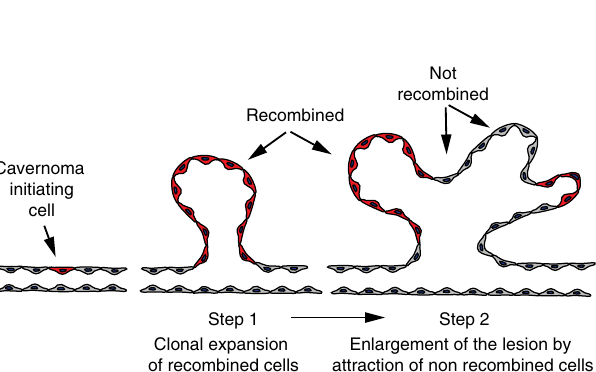
Fig. 8 Endothelial progenitors are involved in cavernomas formation. a In situ hybridization for Procr using the RNAScope assay with chronic Ccm3 − / − cerebral cavernous malformation (CCM) mouse brains. Red, Procr probe; grey, endothelial cells stained with a combination of anti-COLLAGEN IV and anti- ERG1 antibodies. Black and green panels show endothelial cells with high expression of Procr, blue panel shows cells with no expression of Procr. b Quanti fi cation of the percentage of endothelial cells that express Procr within the lesions; n = 10 lesions from 3 animals. c Procr CreERT2-IRES-tdTomato/ + / Ccm3 f/f mice received tamoxifen injection at P1 and were analysed at P30. Representative images of the cerebellum stained for PECAM1 and whole- mount retina stained for Isolectin B4. d Fluorescence-activated cell sorting analysis on endothelial cells isolated from wild-type mice at P2. The plot shows the percentage of Procr + cells among the Cd45 − /Cd31 + endothelial cells. Data are means ± SE; n = 3 animals. e RNAseq analysis on endothelial cells isolated from the brain of wild-type mice at different ages, showing the reduction of Procr expression during development. Data are means ± SE from 3 animals each group. Source data are provided as a Source Data fi le. f Procr CreERT2-IRES-tdTomato/ + / Ccm3 f/f /R26-EYFP mice received tamoxifen injection at P1 and were analysed at P30. Representative images of whole-mount retina stained for Isolectin B4 and EYFP showing endothelial cells lining the lesion that underwent recombination. g – j Representative confocal images of brain sections double stained for PECAM1 (red) and the mesenchymal markers (green) KLF4 ( g ), SCA1 ( h ), FN1 ( i ) and α SMA ( j ). White arrows, cells lining the cavernoma; yellow arrows, cells in normal vessels. Scale bars, 500 μ m